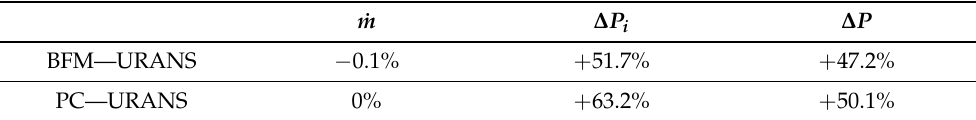
Table 4. Relative discrepancy between URANS and lower-fidelity approaches.